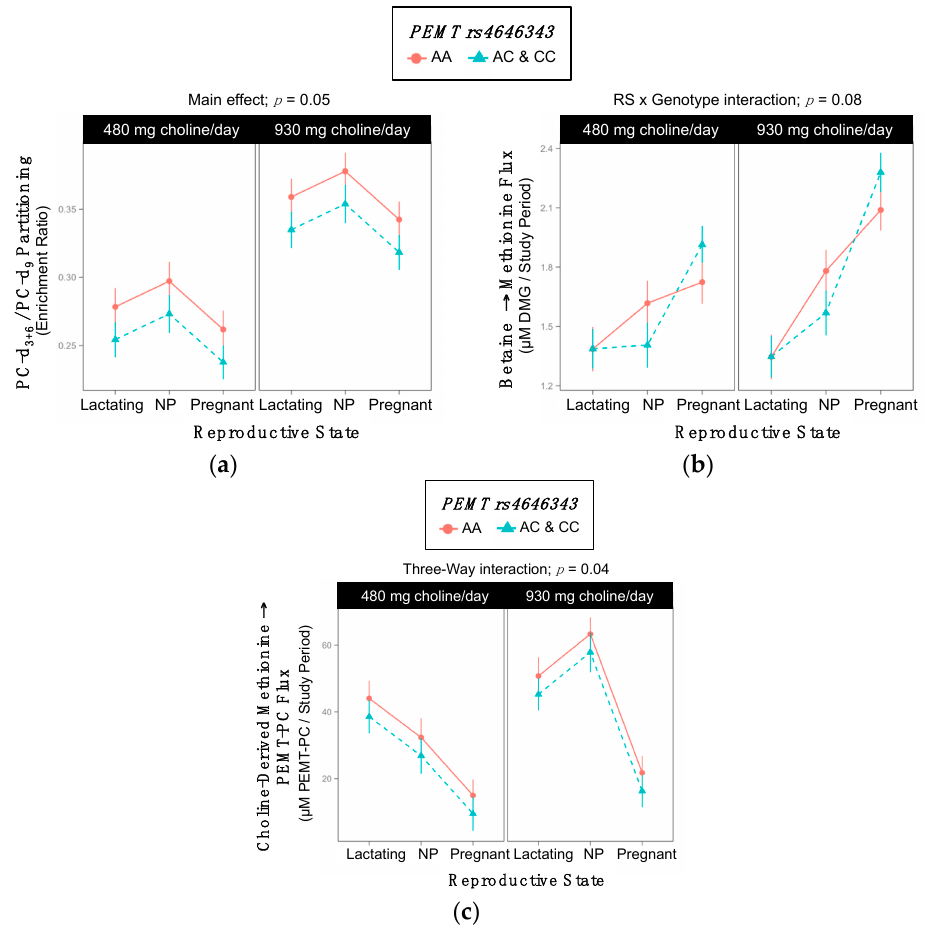
Figure 6. Effect of the PEMT rs4646343 variant on the metabolic flux and partitioning of dietary choline. ( a ) PC-d 3+6 /PC-d 9 partitioning; ( b ) Betaine → methionine flux; ( c ) Choline-derived methionine PEMT-PC flux. Table 10. PEMT rs4646343 genotype alters plasma choline PC-d3+6/PC-d9 enrichment ratios. Values are least-squared means ± standard errors for each group. Values are ratios.